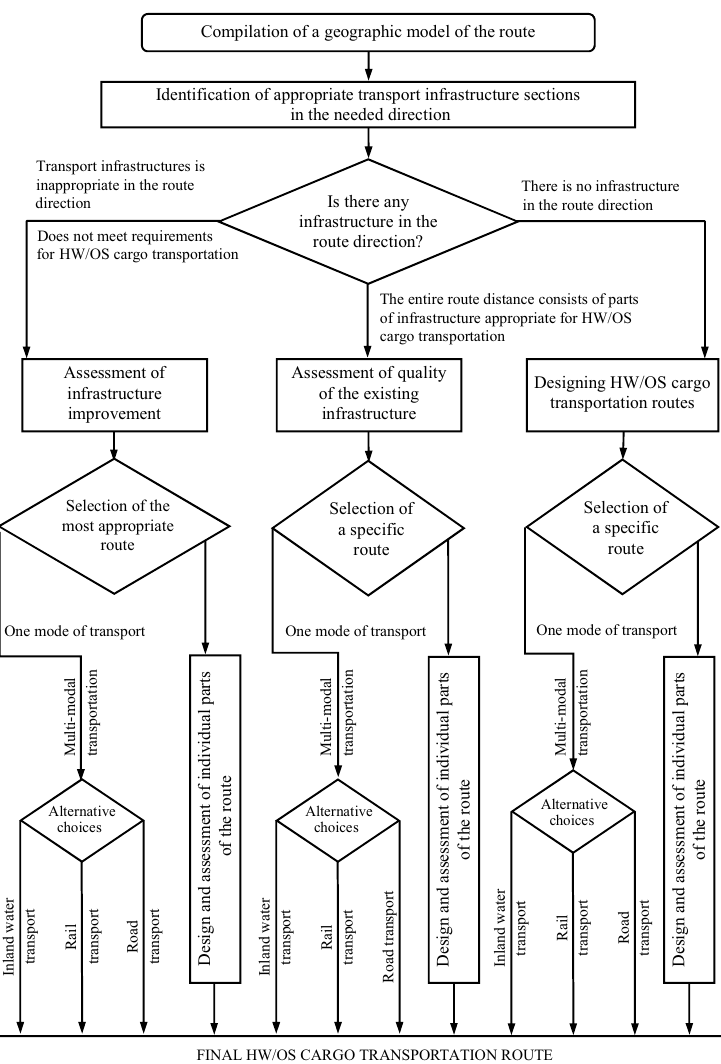
Fig. 1. Algorithm of HW/OS cargo transportation route